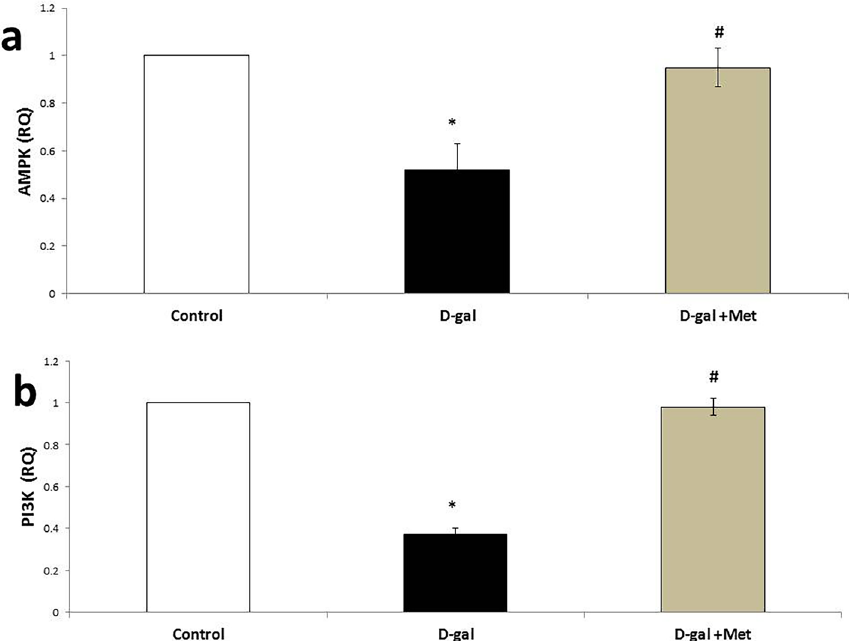
Figure 6. Gene modifying effect of metformin in D-galactose-induced aging rat model (*significant when compared to control group, # significant when compared to D-gal group). Data are shown as means + SD (n = 10). ANOVA was used to make group comparisons; Significance = P <